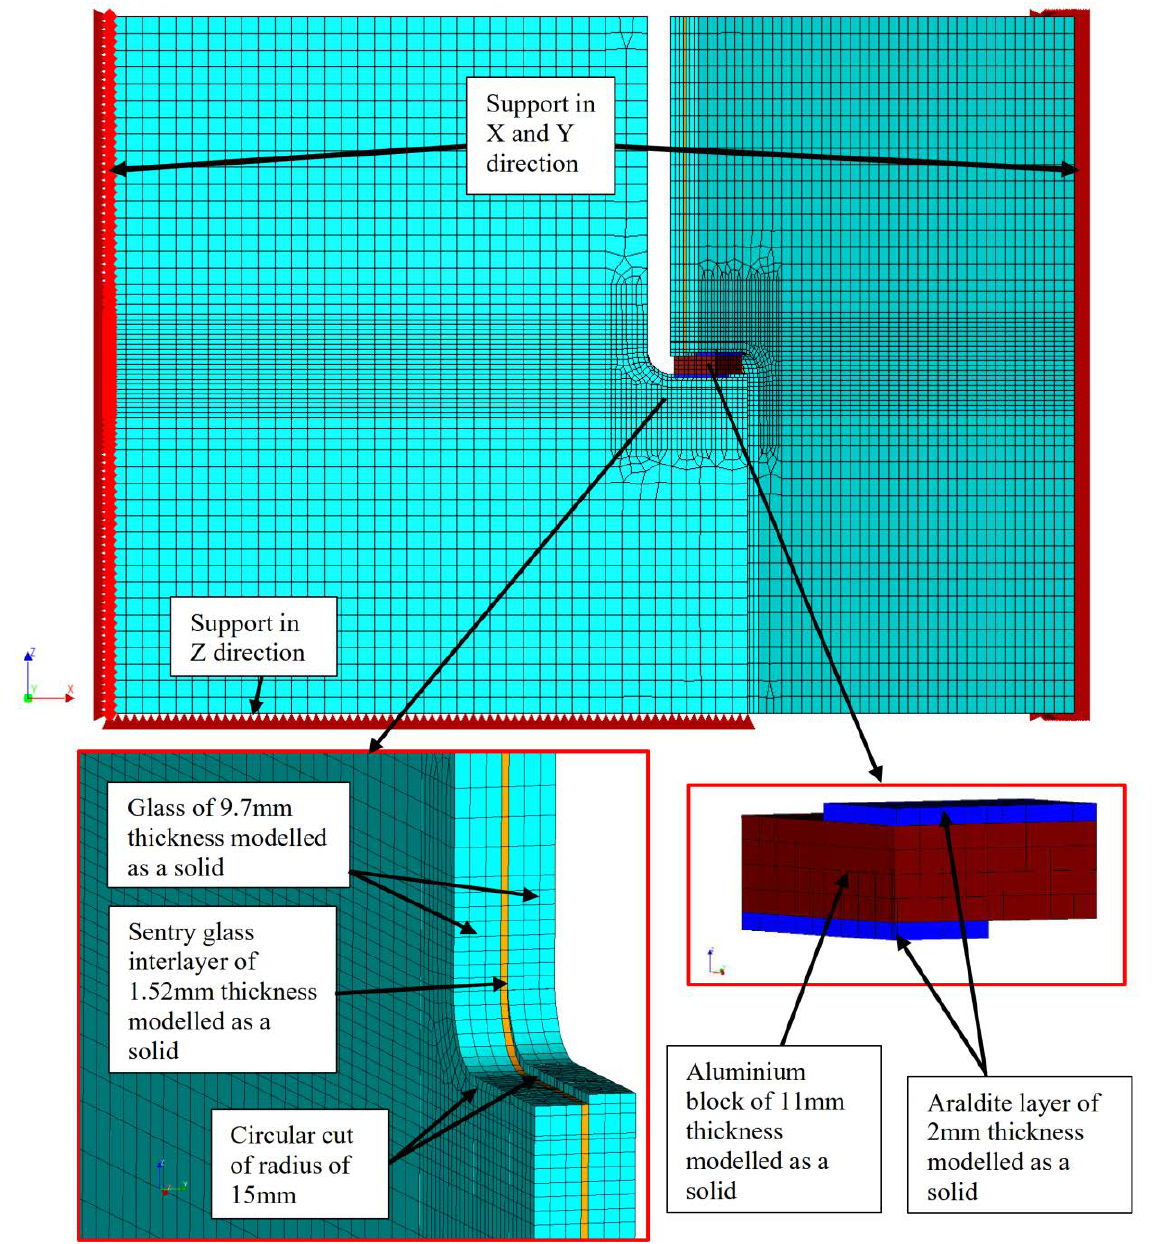
Fig. 10 3D Finite element model in